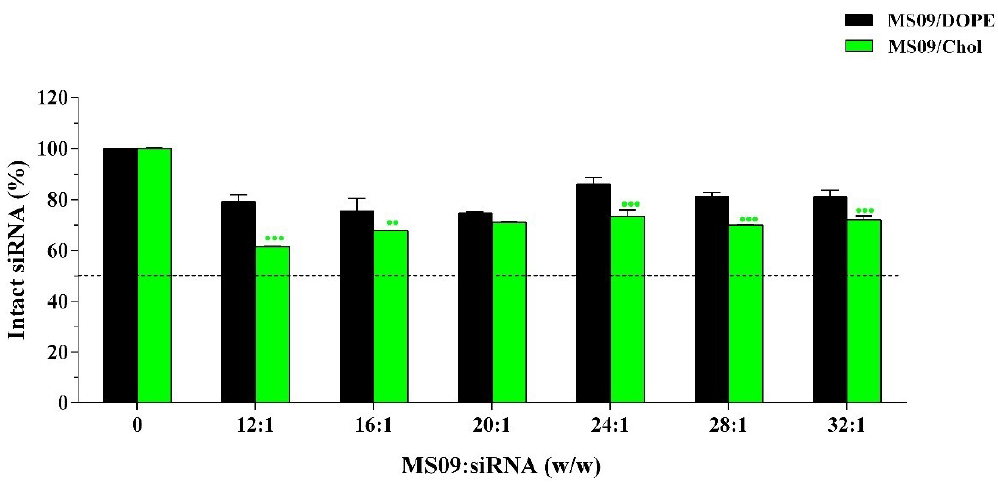
Figure 5. Densitometric analysis of siRNA-protecting capacity of liposomes in the presence of 10% fetal bovine serum. Intact siRNA associated with lipoplexes was quantified and expressed as a percentage of untreated siRNA (0.3 μg). Data is presented as the mean ± SD ( n = 3). ●● P < 0.01, ●●● P < 0.001 vs. DOPE-containing